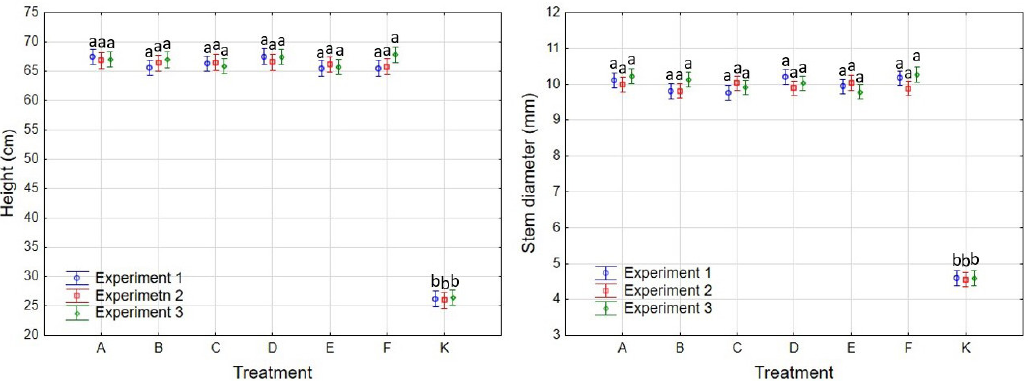
Figure 2. The height ( left ) and the stem diameter ( right ) of seedlings that had emerged from seed after different pre-sowing treatments: A moistening, 7-day anaerobic and 10-day aerobic fermenta- tion of seeds from Uherské Hradiště, B moistening, 7-day anaerobic and 20-day aerobic fermenta- tion of seeds from Uherské Hradiště, C moistening, 7-day anaerobic and 30-day aerobic fermenta- tion of seeds from Uherské Hradiště, D moistening, 7-day anaerobic and 10-day aerobic fermenta- tion of seeds from Slušovice, E moistening, 7-day anaerobic and 20-day aerobic fermentation of seeds from Slušovice, F moistening, 7-day anaerobic and 30-day aerobic fermentation of seeds from Slušovice, K warm-cold stratification of seeds from Uherské Hradiště at the end of the growing season in Experiments 1, 2 and 3 (different letter indexes denote statistically significant differences between the various treatments).